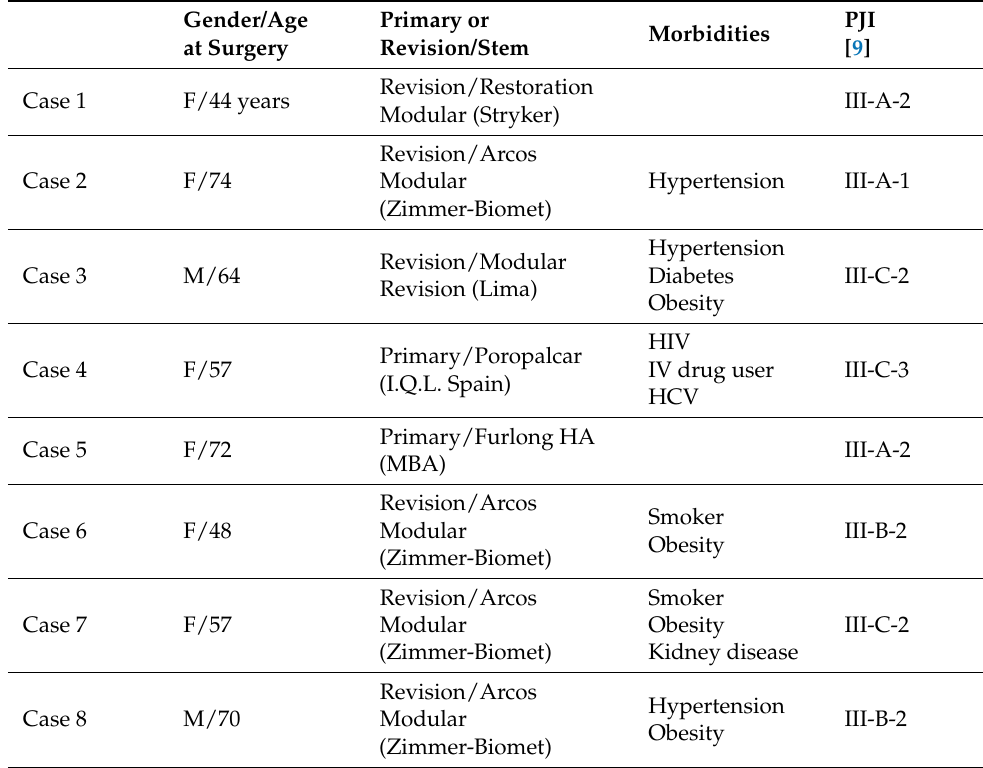
Table 1. Demographic characteristics. F: female; M: Male; HIV: human immunodeficiency virus; HCV: hepatitis C